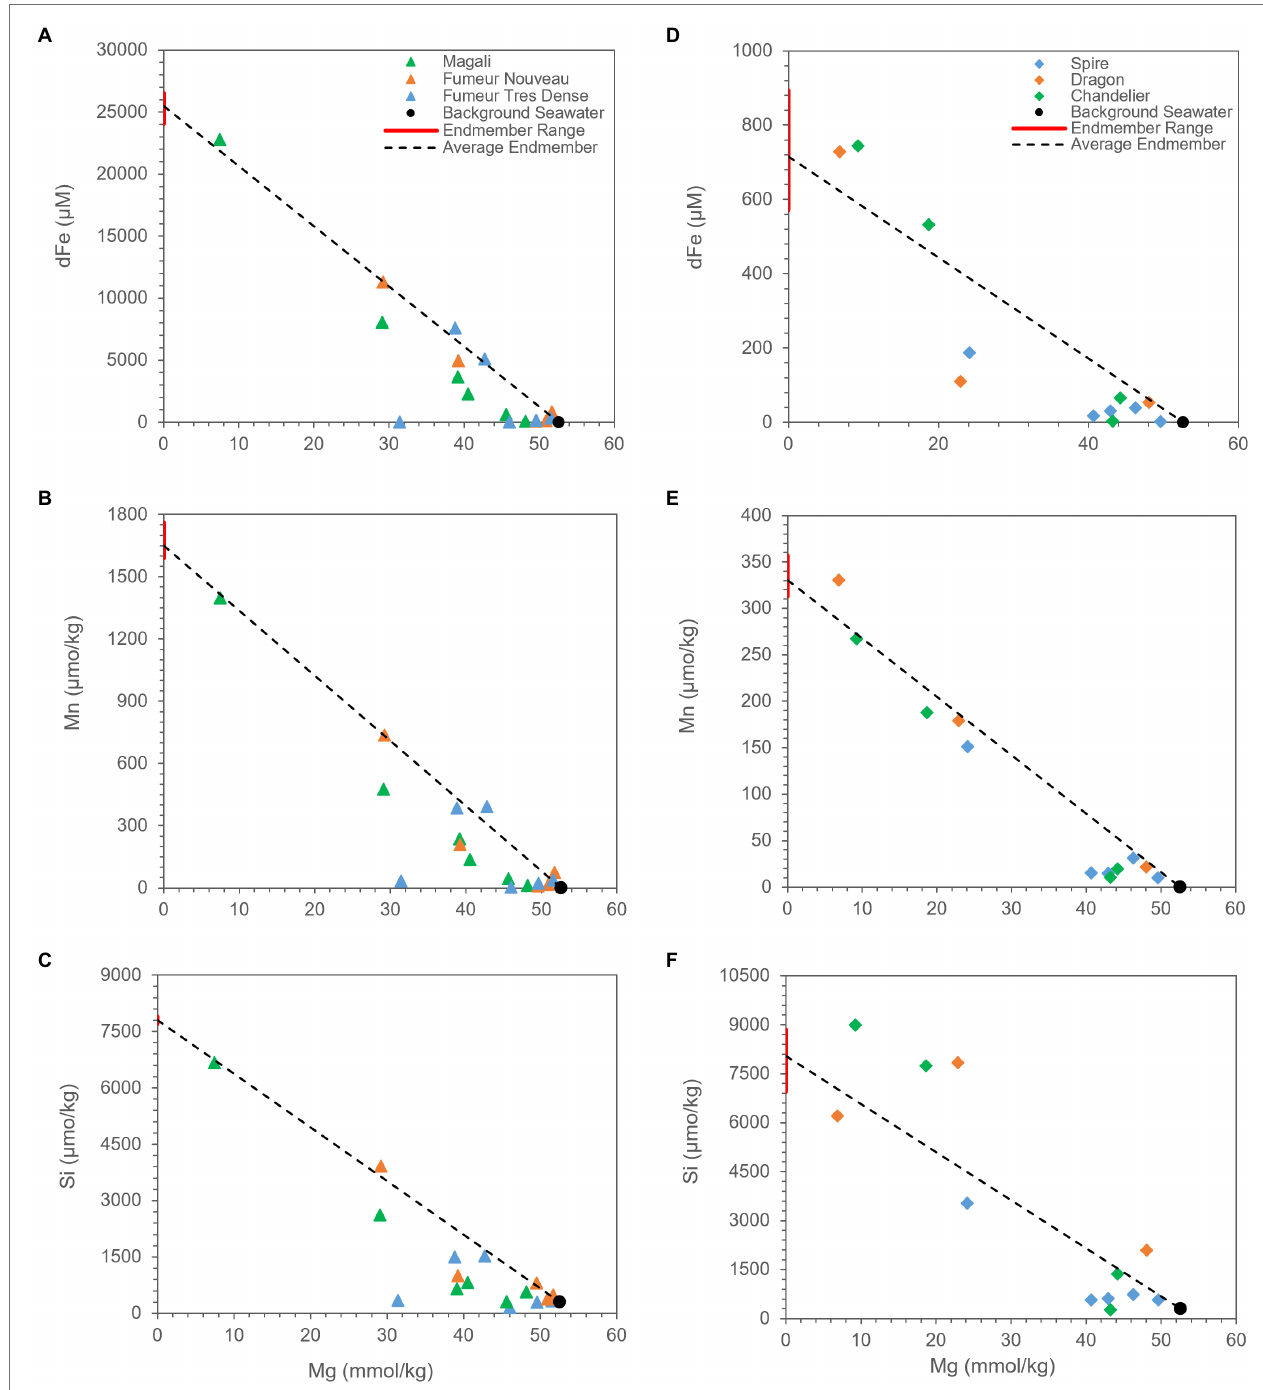
FIGURE 5 | Measured concentrations of aqueous Mg vs. dFe, Mn, and Si for fluid samples from Rainbow (A–C) and Broken Spur (D–F) vents. For each species, the range in extrapolated zero Mg high-temperature end-member composition is shown with the red bar along the y axis, and the average is shown with a black line projected from seawater composition. Species that exhibit conservative behavior during mixing plot on the line, while species that behave non-conservatively plot above or below the